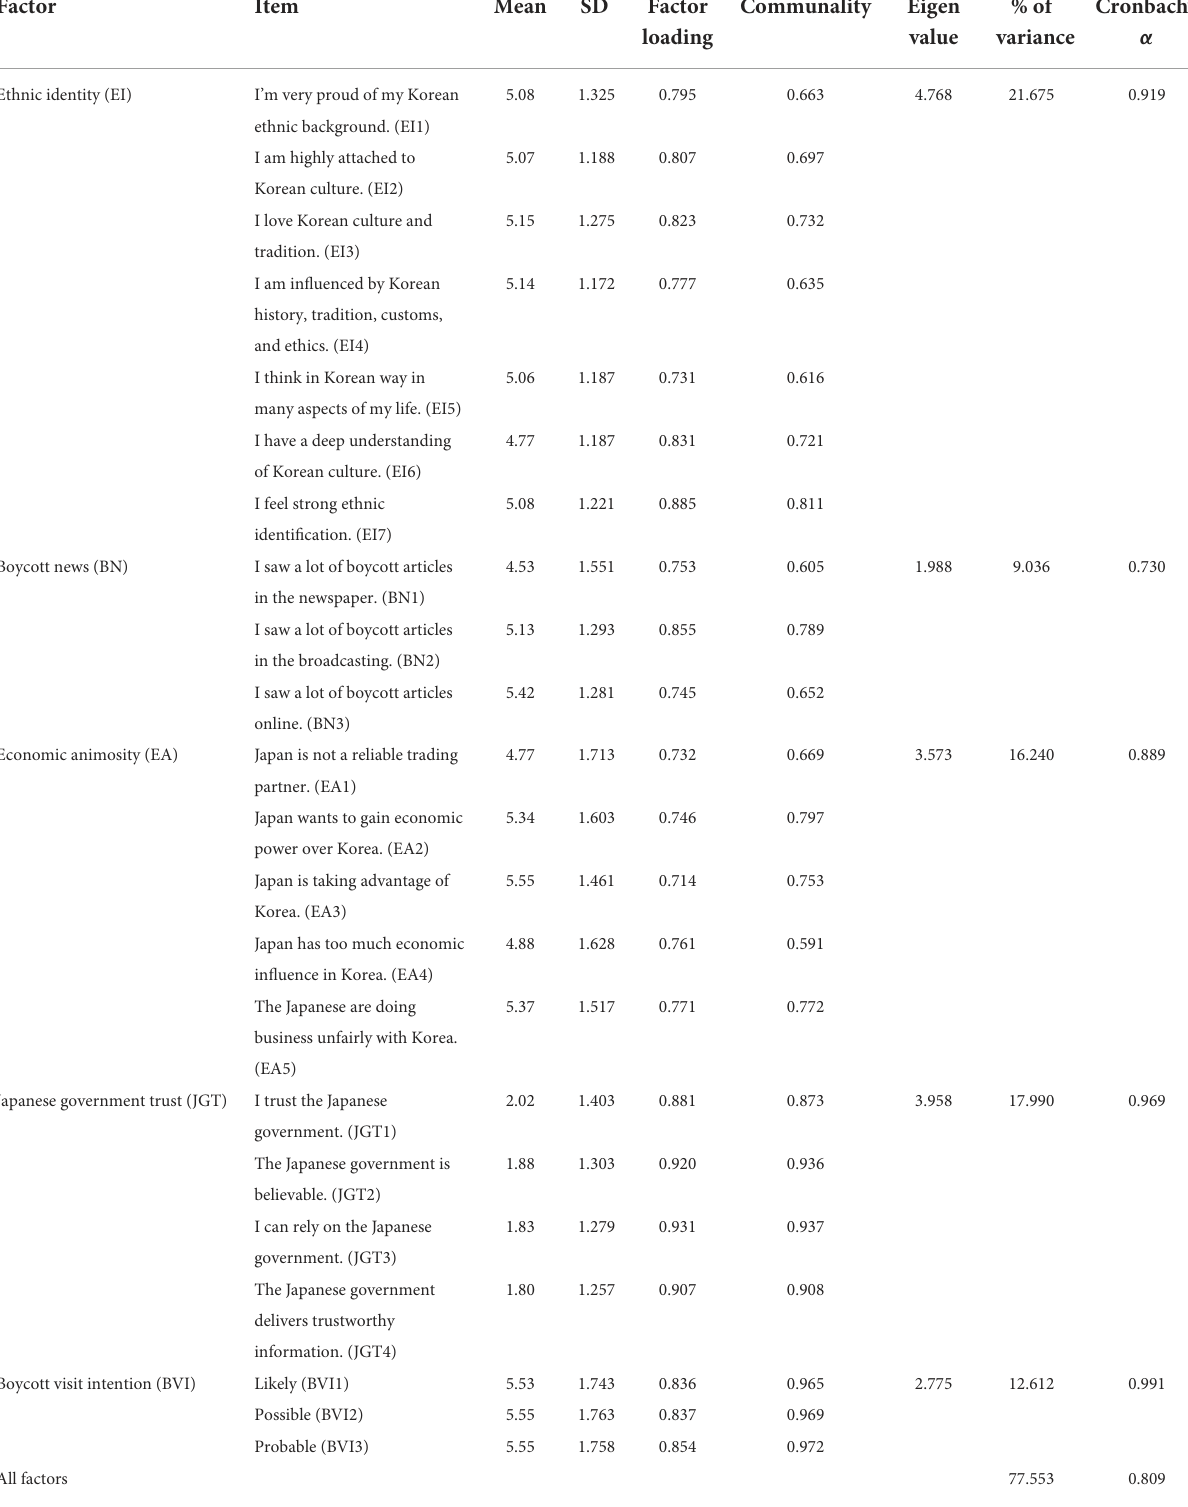
TABLE 3 Results of EFA and reliability analysis. Factor Item Mean SD Factor